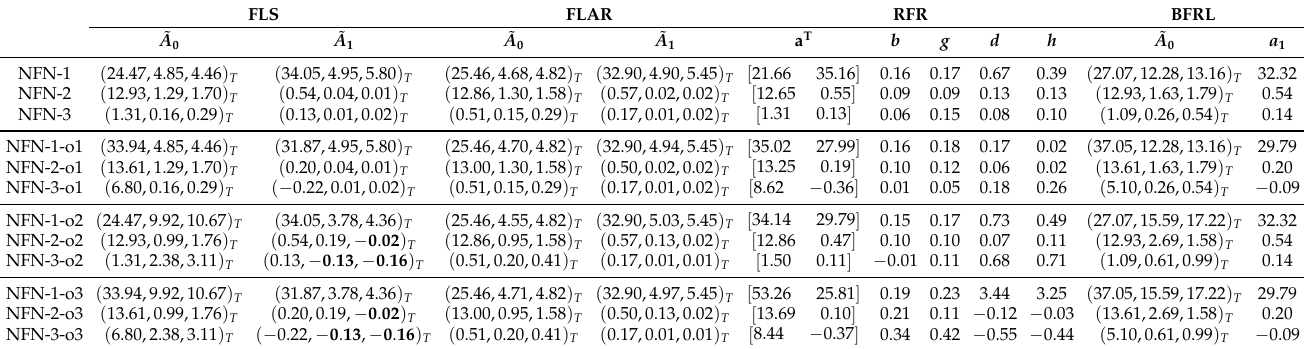
Table 8. Parameters of fuzzy regression models ˜ A 0 , ˜ A 1 , a , b , g , d , h and a 1 estimated by the fuzzy least squares (FLS), the fuzzy least absolute linear regression (FLAR), the robust fuzzy regression (RFR) analysis, and the Boscovich fuzzy regression line (BFRL) on datasets (first column) with non-symmetric fuzzy observations. Negative spreads are in